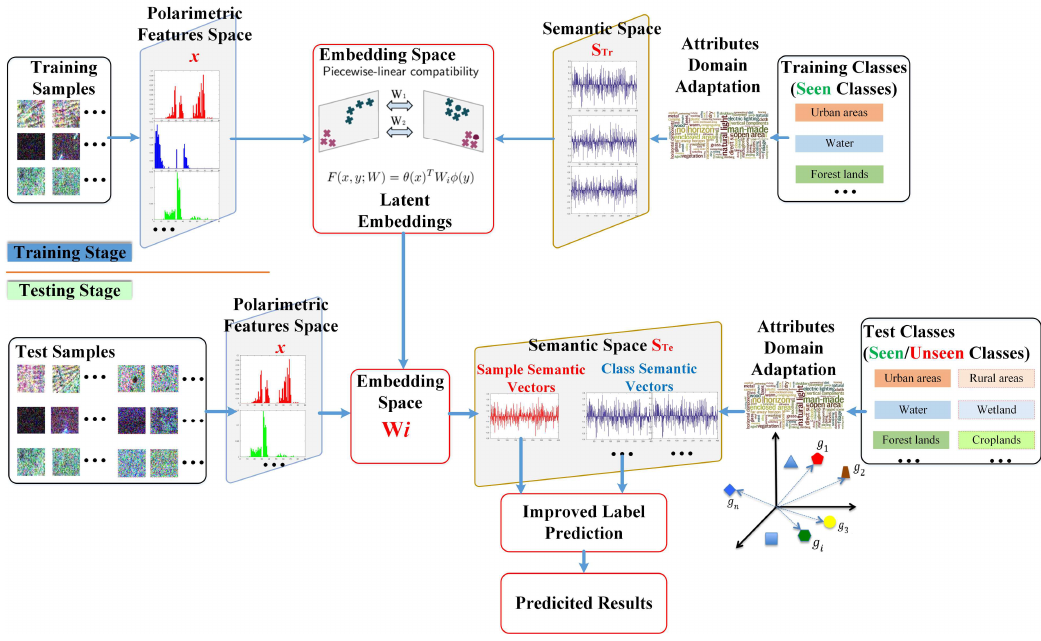
Figure 2. The flowchart of the proposed method.